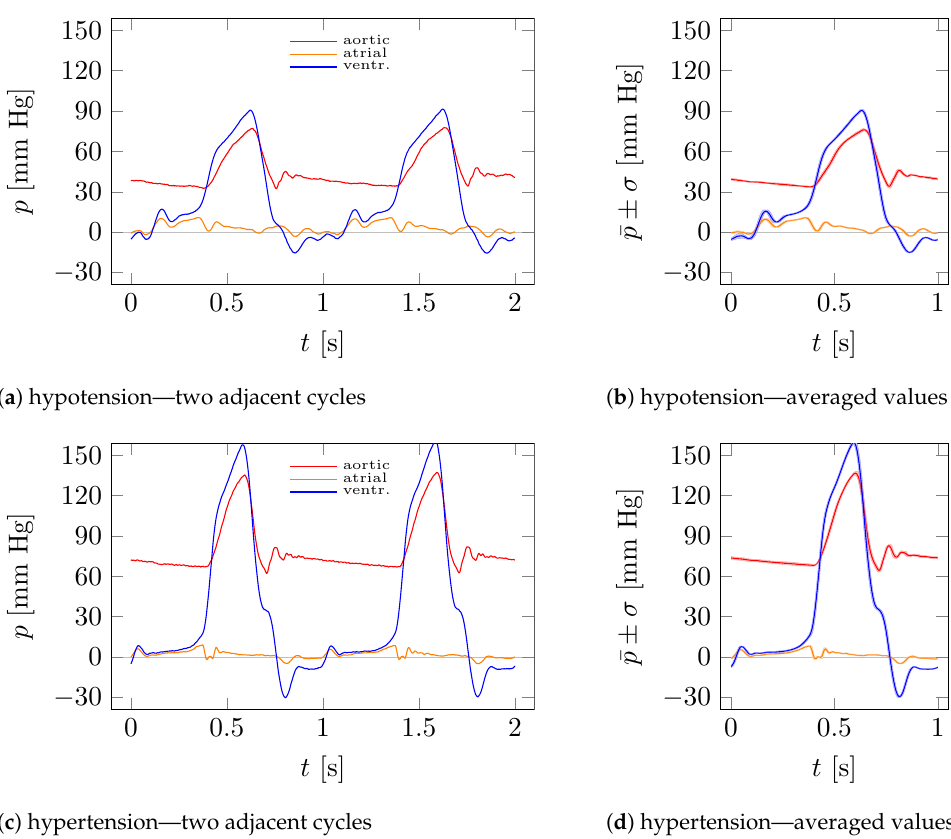
Figure 7. Experimental results—aortic, atrial and ventricular pressure